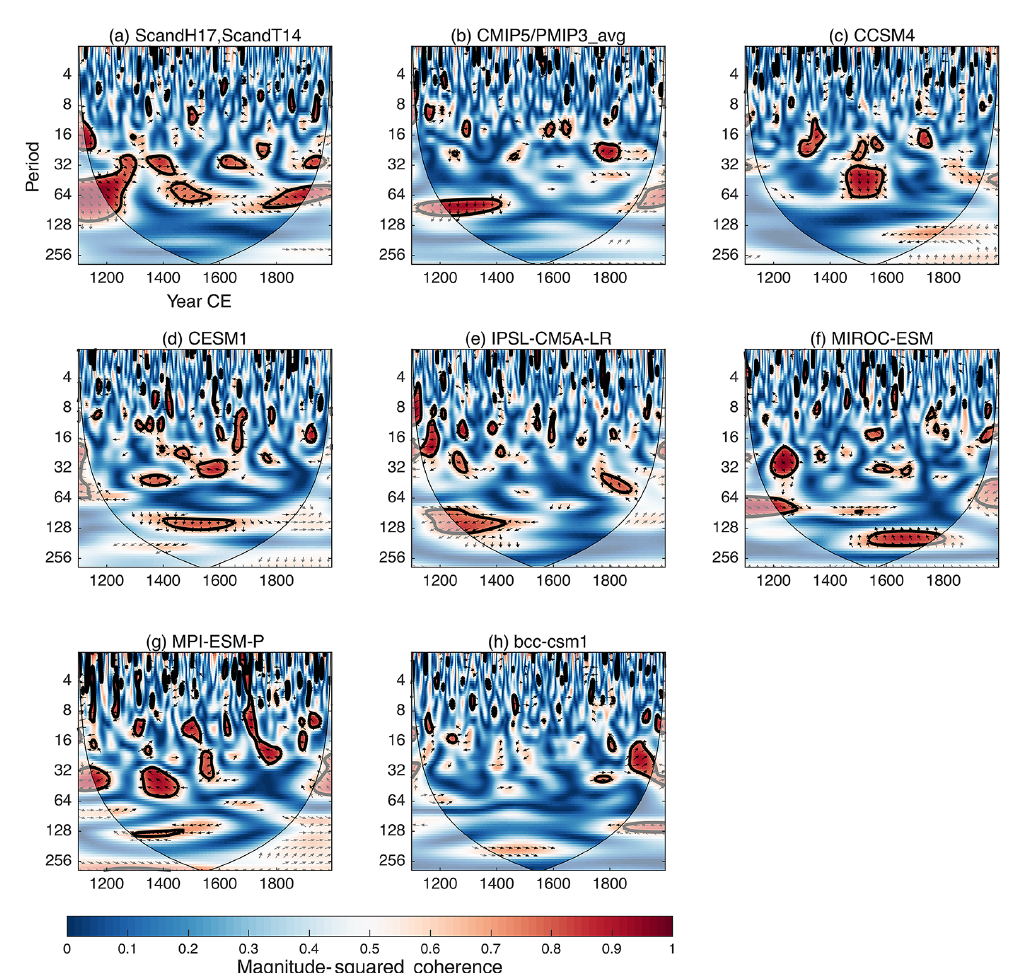
Figure 8. Squared wavelet coherence and phase between (a) ScandH17 and ScandT14, and (b) – (h) CMIP5–PMIP3 simulations of temper- ature and rainfall. The arrows indicate the relative phase relationship between two series; arrow pointing right (left) indicates in-phase (180 ◦ out of phase) relationship. Significant coherence at 95% significance level is shown as a thick